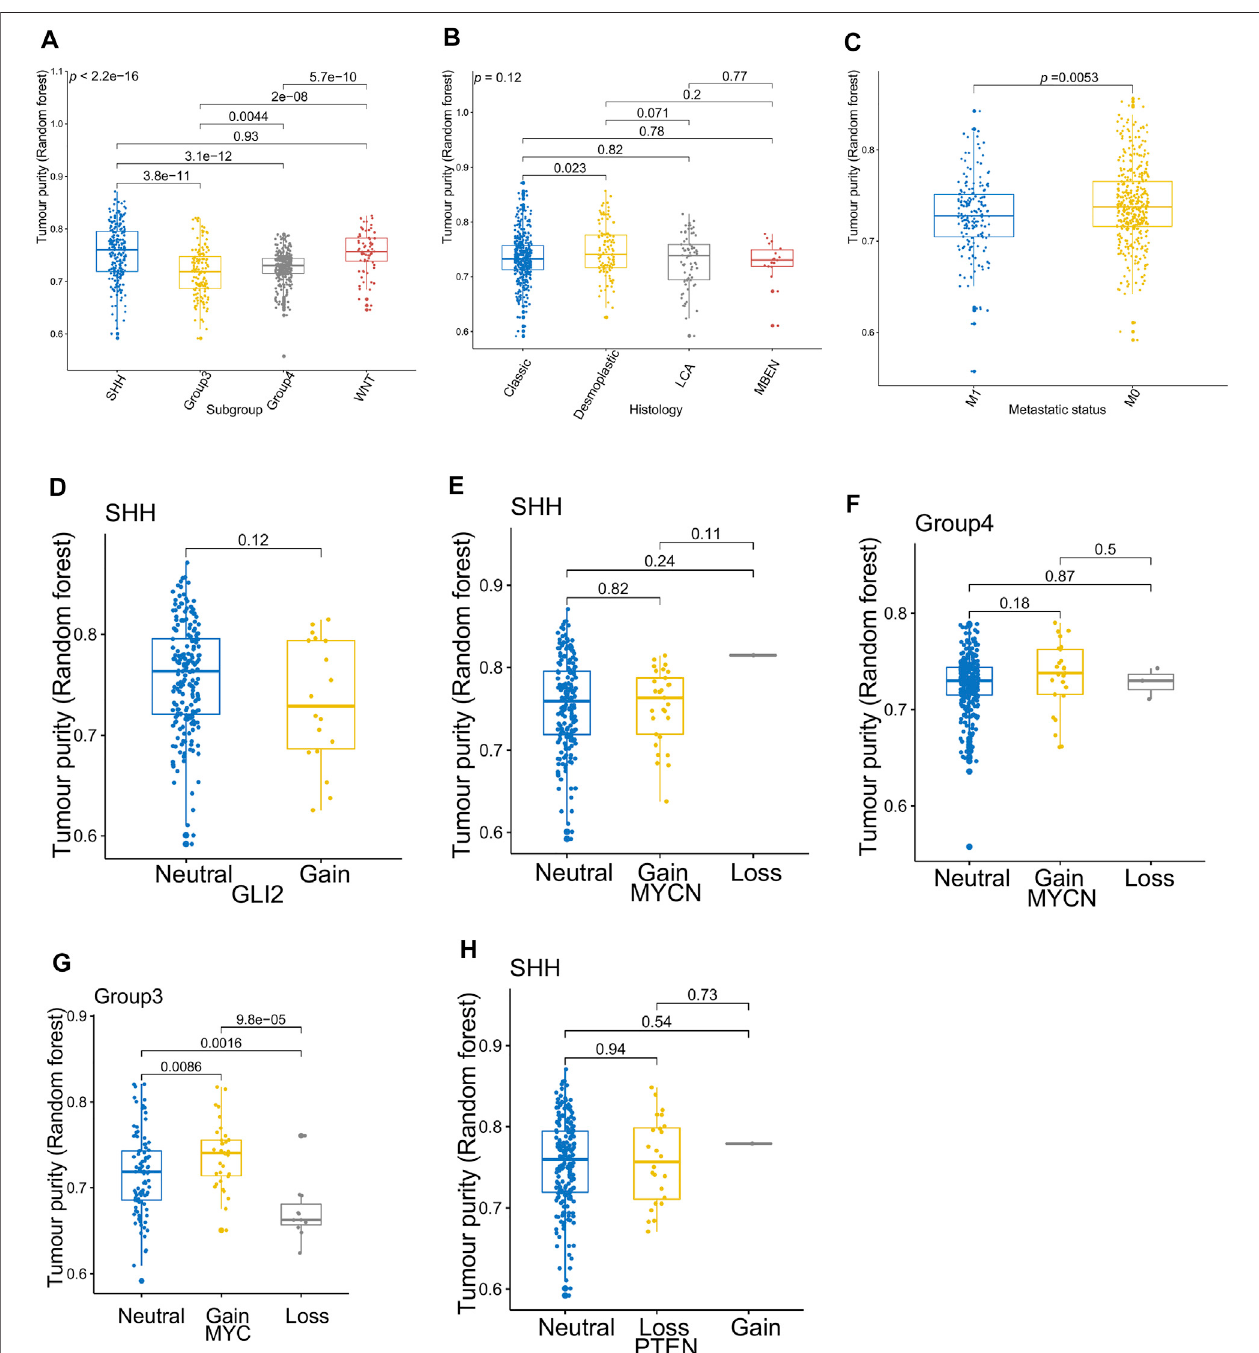
FIGURE 5 | Relationship between the tumor purity of the medulloblastoma (MB) and its clinical molecular features in the GSE85218 dataset. (A) Box plot of the tumor purity by molecular subgroup; (B) box plot of the tumor purity by histopathology; (C) box plot of the tumor purity by metastatic status; (D) box plot of the tumor purityoftheSHHsubgroupbyGLIampli fi cation; (E) boxplotofthetumorpurityoftheSHHsubgroupbyMYCNampli fi cation; (F) boxplotofthetumorpurityoftheGroup 4 subgroup by MYCN ampli fi cation; (G) box plot of the tumor purity of the Group 3 subgroup by MYC ampli fi cation; (H) box plot of the tumor purity of the SHH subgroup by PTEN